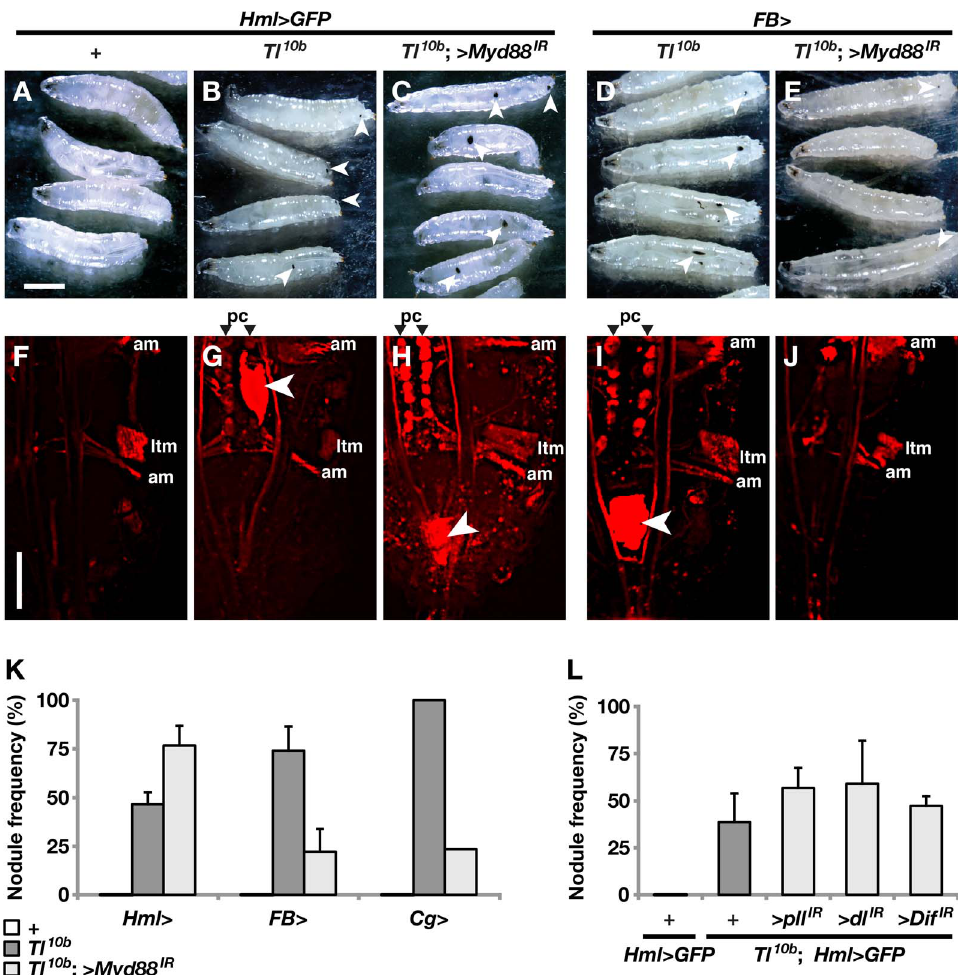
Figure 3. Toll-dependent formation of melanotic nodules requires Toll signaling in fat body but not in the hemocytes. A–E . Control ( + ) or Toll 10b gain-of-function mutant ( Tl 10b ) third instar larvae are shown with or without suppression of Toll signaling by the UAS-MyD88 GD25399 construct ( . MyD88 IR ), driven in hemocytes by Hml D -Gal4 ( Hml . ) or in fat body by FB-Gal4 ( FB . ). Melanotic nodules are seen as black spots, as indicated by white arrowheads. F–J . Expression of the lamellocyte marker msn-Cherry in larvae of the same genotypes as in A–E. The posterior ends of the larvae are shown. Lamellocytes are incorporated in nodules (white arrowheads). Free lamellocytes can also be seen as small red dots in H and I. Strong ectopic expression of the msn-Cherry marker is seen in lateral transverse muscles (ltm) and alary muscles (am). In Toll 10b mutants (G–I) it is also expressed in pericardial cells (pc), except when Toll is suppressed in the fat body (J). K–L . Bars represent the average frequency + / 2 standard deviation of larvae with at least one melanotic nodule, as calculated from three independent crosses for each of the genotypes described above, with 50 larvae in each experiment. In a single experiment, Toll signaling was simultaneously suppressed in hemocytes and fat body by the Cg-Gal4 driver ( Cg . ). Size bars in A–E correspond to 1 mm and in F–J to 0.2